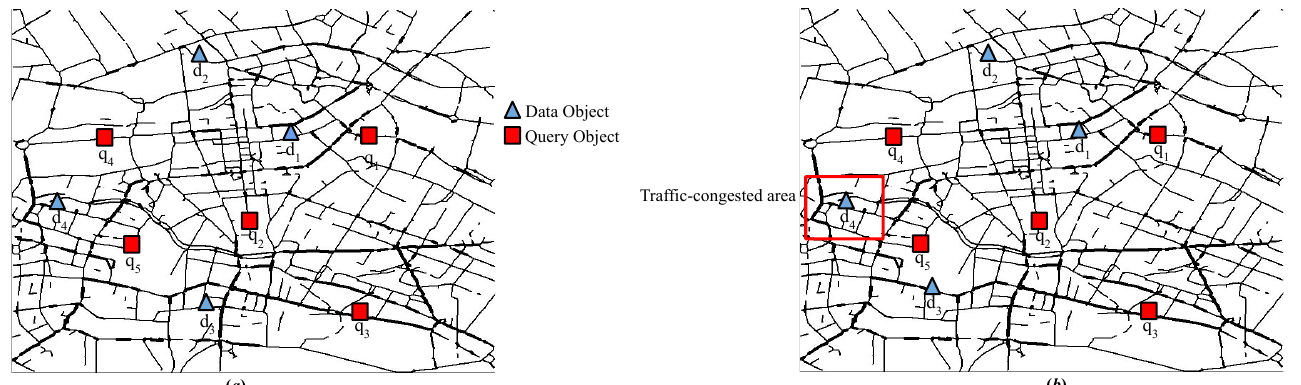
Figure 1. Example of dynamic road network ( a ) traffic condition at time t 1 ; ( b ) traffic condition at time t 2 where, (cid:8) (cid:9) (cid:8) (cid:9) Q = q 1 , q 2 , q 3 , q 4 , q 5 d 1 , d 2 , d 3 , d 4 and D =